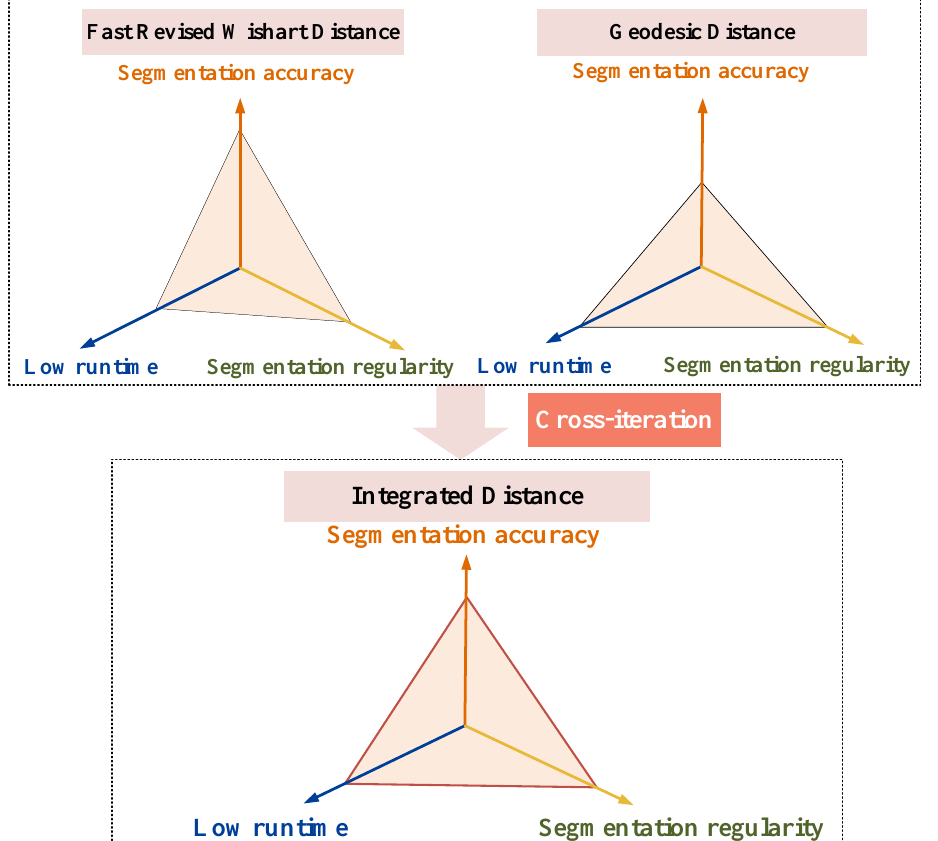
Figure 4. Advantages of the proposed